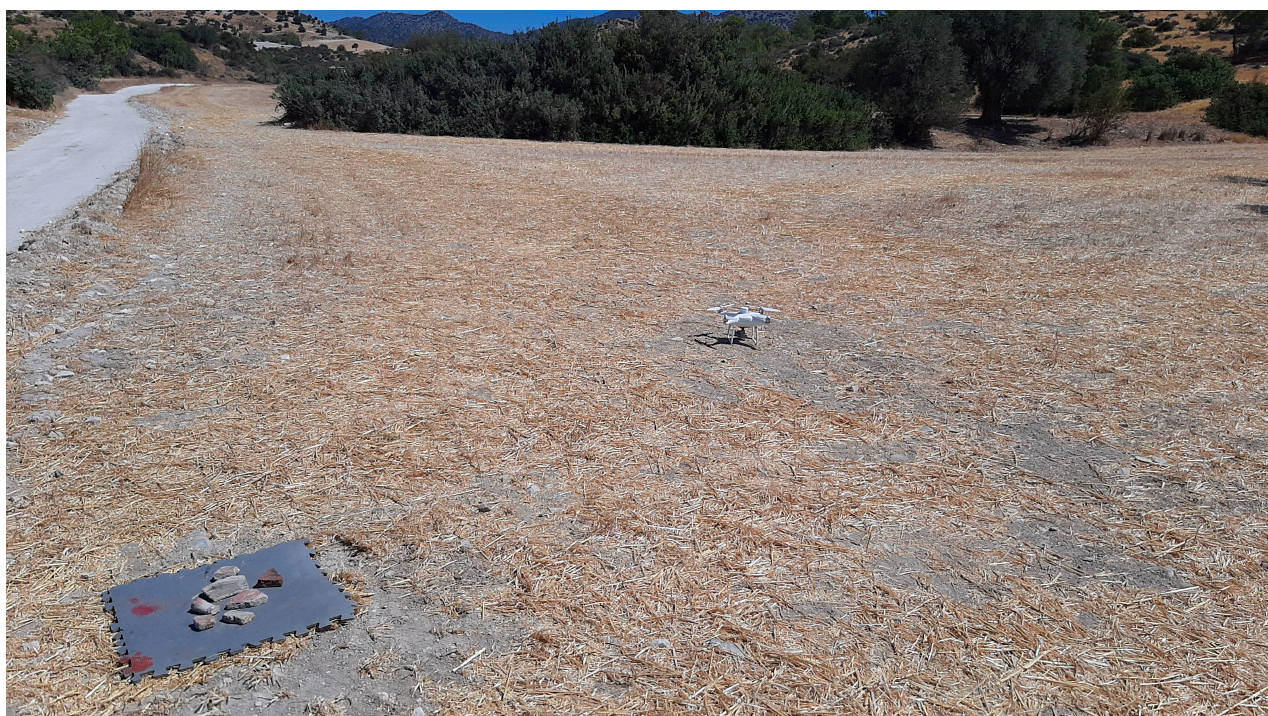
Figure 3. A photo taken during the UAV multispectral campaign over Area 6 in 2021. Stereo pairs from the high-resolution images were collected from both campaigns